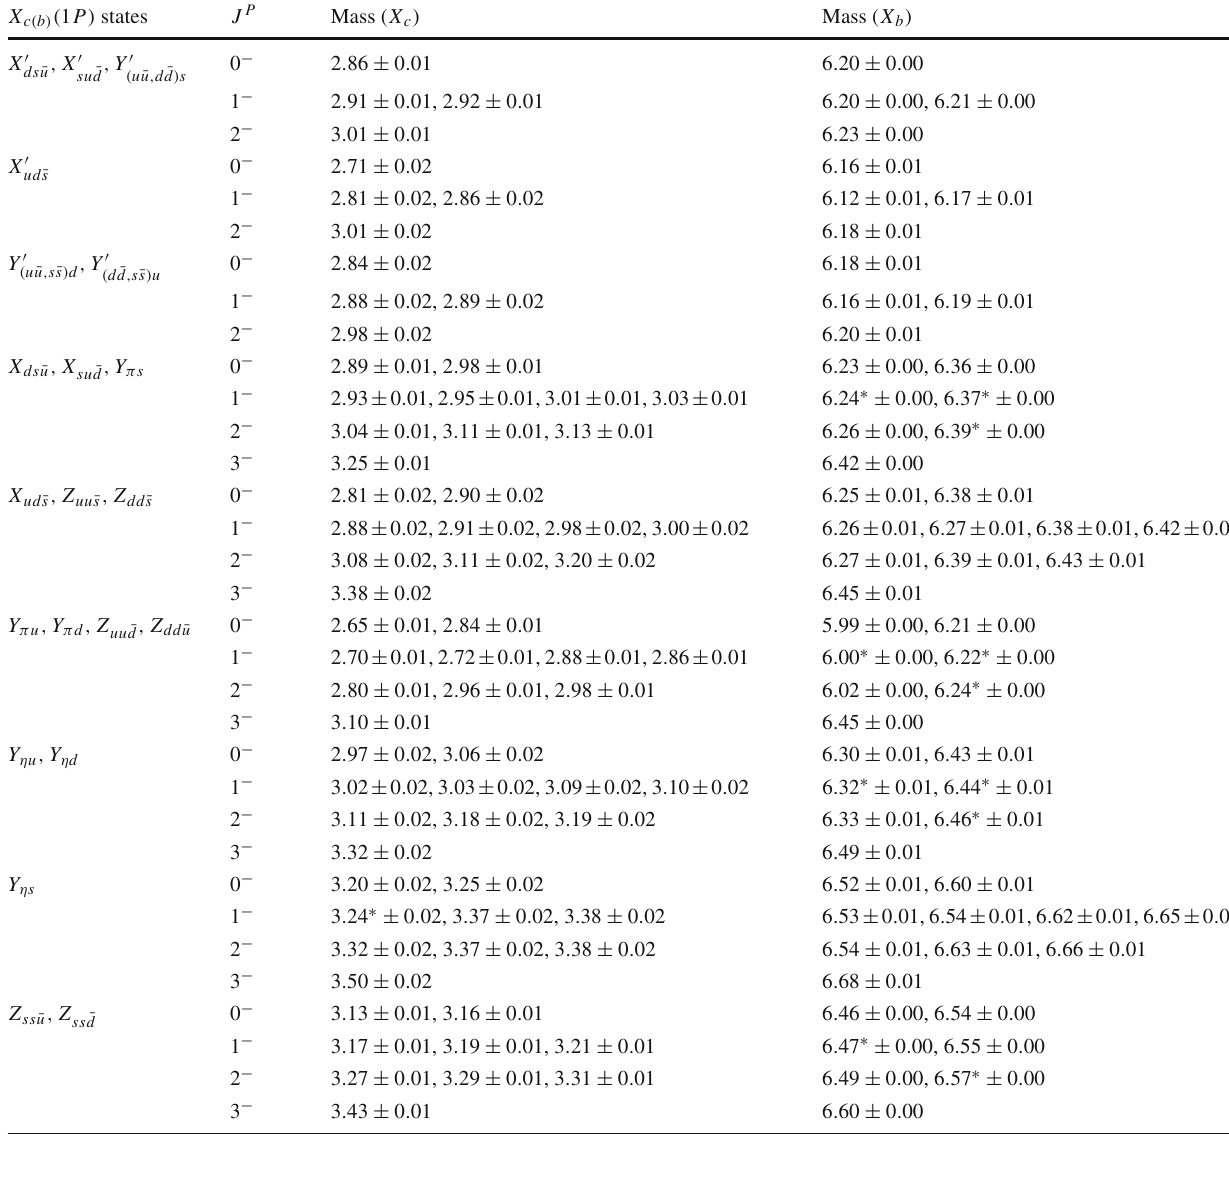
umn, different J P numbers are listed for these particles. In the table two or more different masses appear in identical J P for some states because of hyperfine splitting from spin-spin or spin-orbital coupling. The same reason also give more than one entries in Table 2. The mass denoted a “*” means two degenerate states. The uncertainty is from quark